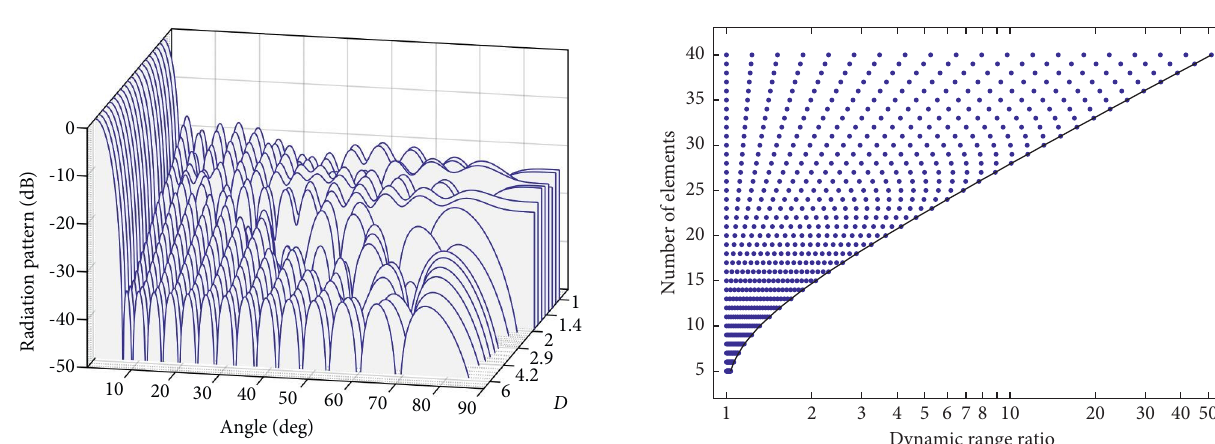
Figure 4: Radiation patterns of pencil beam arrays with 30 ele- ments and beamwidth of 12 ° , obtained by minimization of SLL and DRR constrained to various values between D � 1 and D �